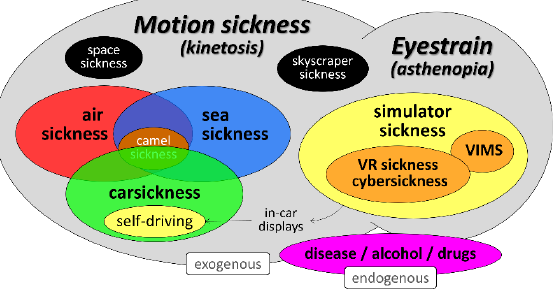
Figure 1. Motion sickness taxonomy reflecting the conditions in which motion sickness and eye strain can occur. Note that the symptoms of motion sickness are not only caused be external (exogenous), physical, and/or visual motion, but may also be brought about in the absence of these stressors in the case of defects within the vestibular system, causing (endogenous) motion illusions. Adapted from [56].